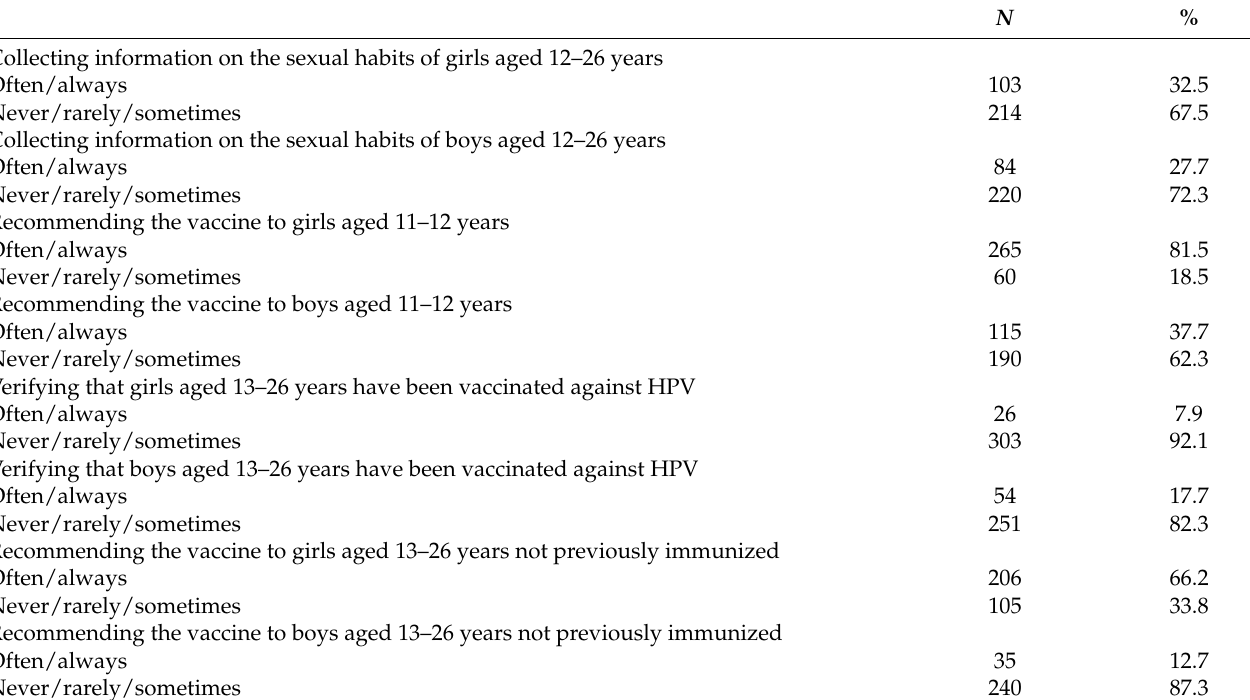
Table 3. Behaviors of the General Practitioners GPs respondents towards human papillomavirus (HPV) vaccination.